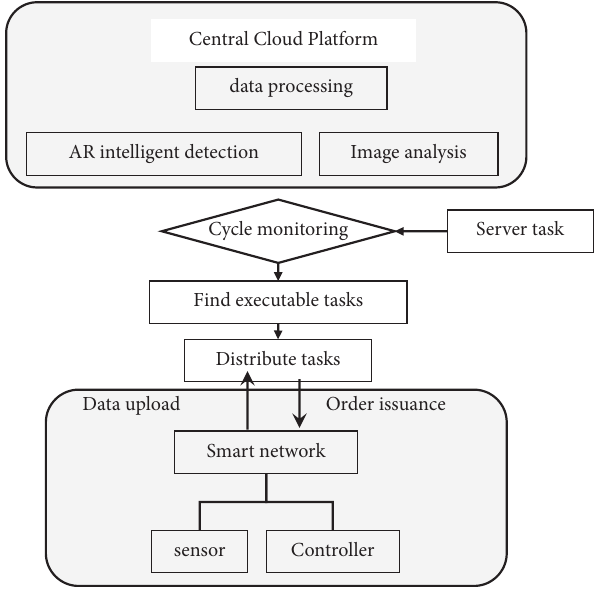
Figure 3: Algorithm